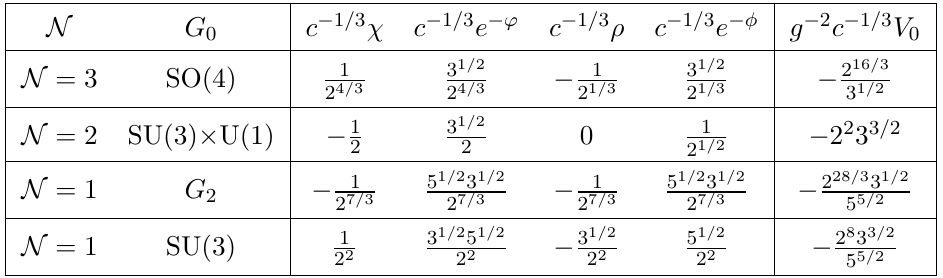
Table 1 . All known supersymmetric critical points of dyonic ISO(7)-gauged N = 8 supergravity. and the holomorphic superpotential